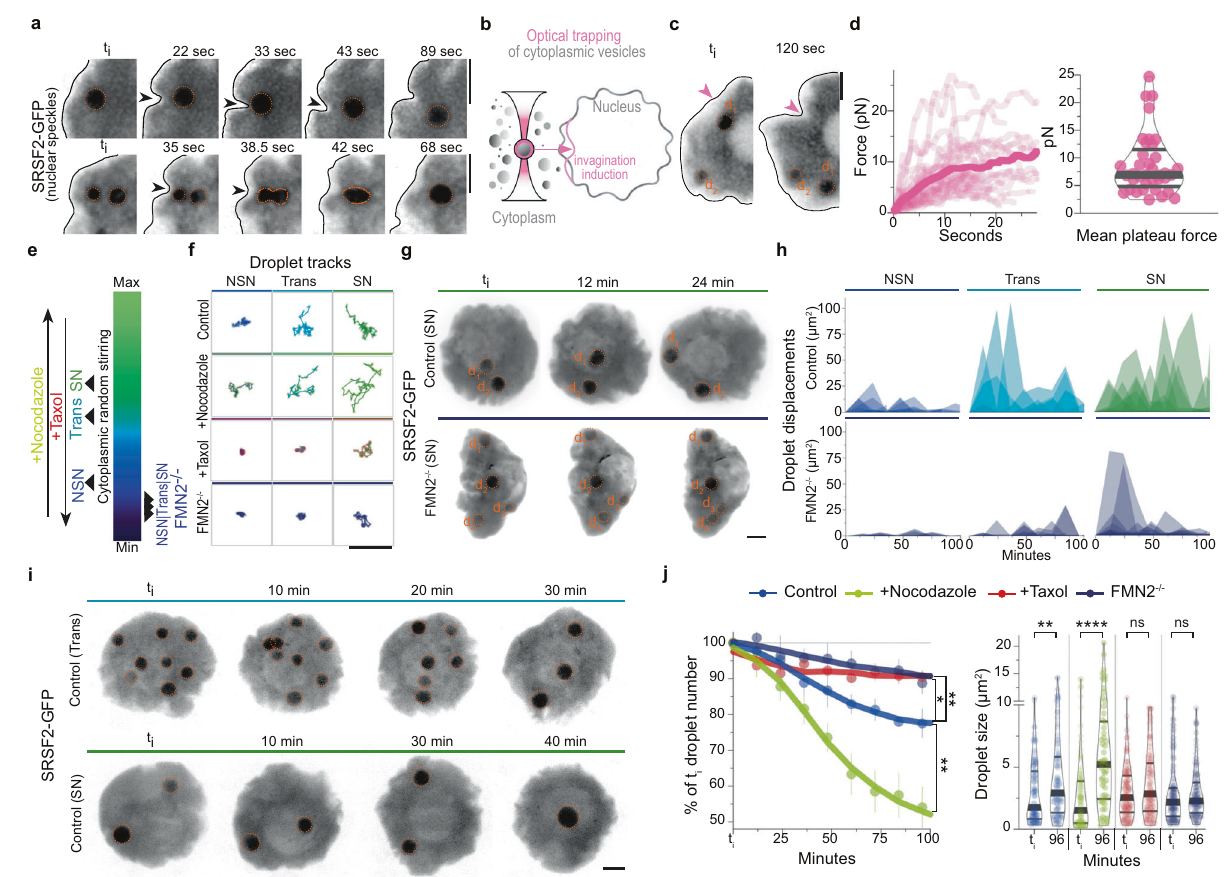
Fig.2|Cytoplasmicforcesdrivemesoscalecondensatecollision-coalescencein the nucleus. a Time-lapse images of nuclear membrane invaginations displacing nucleoplasmic SRSF2-GFP droplets in Trans (top) or NSN (bottom) cells; black arrowheads indicate nuclear membrane invaginations; membrane outlined in black. b Illustration of optical trapping experiment; cytoplasmic vesicles close to thenucleusweretrappedandpushedagainstthenuclearmembranetoexertforces and induce nuclear membrane invaginations. c Time-lapse showing a nuclear membrane invagination induced by the optical trapping approach, displacing a nucleoplasmic SRSF2-GFP droplet in a Trans cell; pink arrowhead indicates a point of contact between the trapped vesicle and nuclear membrane. d Individual force tracksintime (left)and meanplateauforces(right)obtained withopticaltrapping; 37 measurements from 20 oocytes. e Color gradient representing the intensity of cytoplasmicforcesingrowingControlandmutantoocytesorControlstreatedwith microtubule inhibitors. f Representative SRSF2-GFP droplet 2D-space exploration (50s-tracks)atthethreegrowthstagesinControloocytes,Controlsincubatedwith Nocodazole or Taxol, and FMN2 − / − oocytes. g Time-lapse 50 μ m z-projections of SRSF2-GFP droplet displacements in the nucleoplasm of fully-grown SN Control